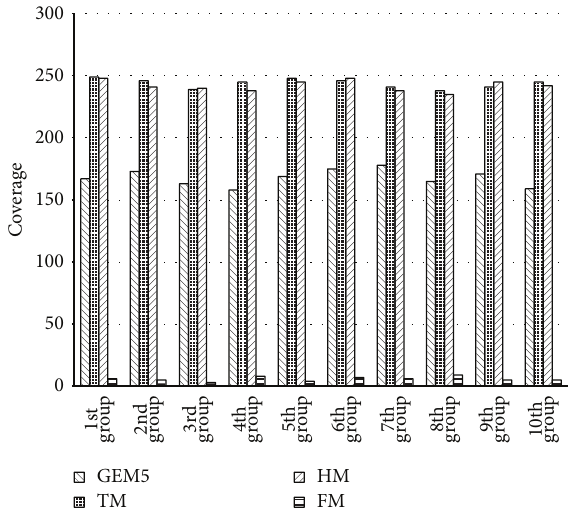
Figure 13: Coverage of function points.